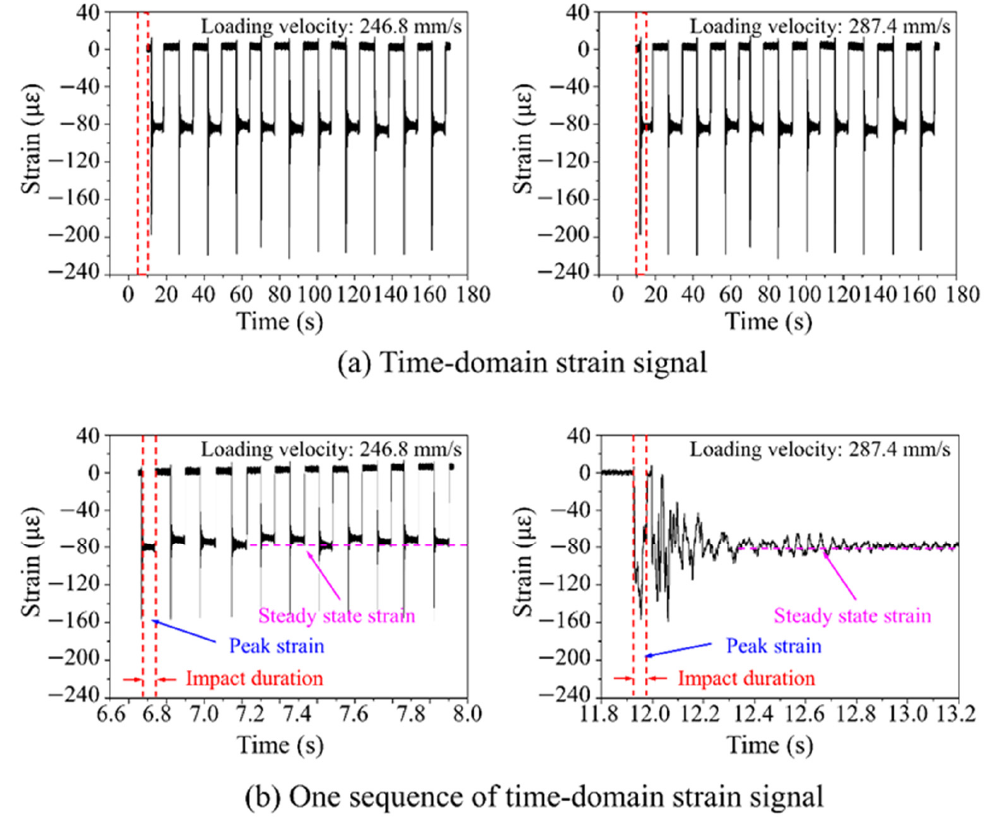
Figure 7. Results of impact experiments. ( a ) Time-domain strain signal measured by impact load transducer during 11 consecutive impacts; ( b ) a sequence of time-domain strain signal. Table 3. Peak strain, impact duration, and steady state strain measured in 11 sets of experiments for two loading velocities.